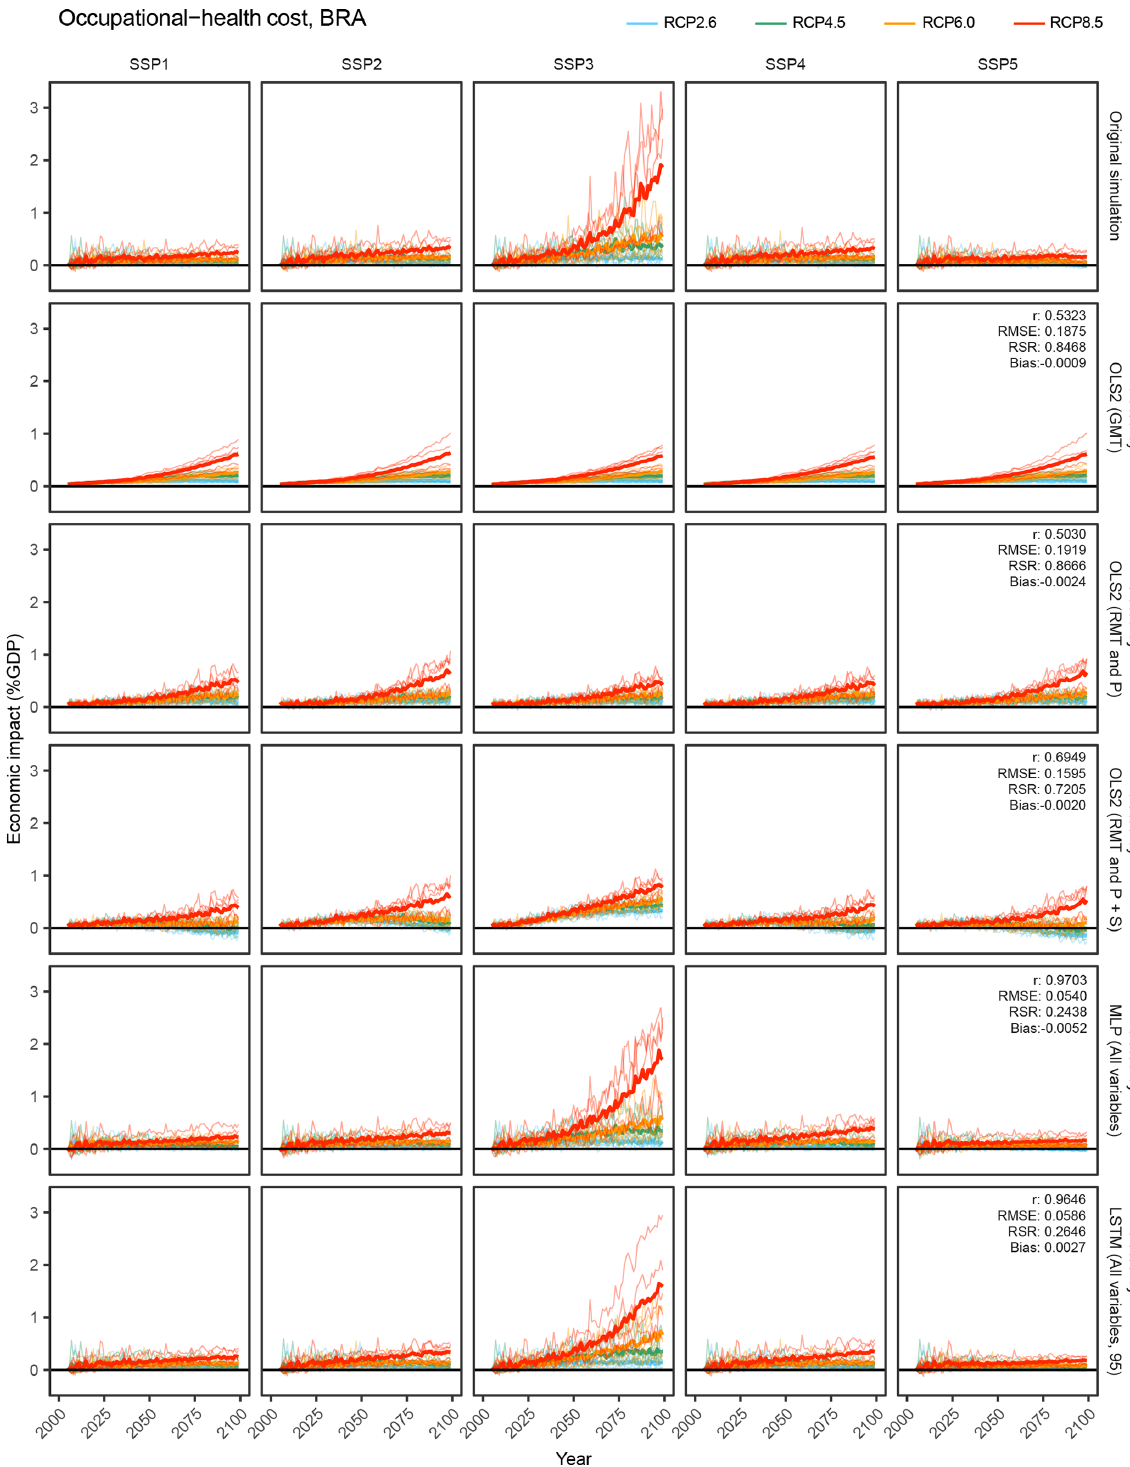
Figure 9. Time-series results of the simulation and emulations for the occupational-health cost sector in the Brazil region. OLS2 (GMT): OLS2 with global mean temperature. OLS2 (RMT and P): OLS2 with regional mean temperature and precipitation. OLS2 (RMT and P + S): OLS2 with regional mean temperature precipitation and socioeconomic variables. MLP (All variables): MLP with all the input variables. LSTM (All variables, 95): LSTM with all the input variables for 95 years. Thin lines represent individual GCM results, and bold lines represent average of five